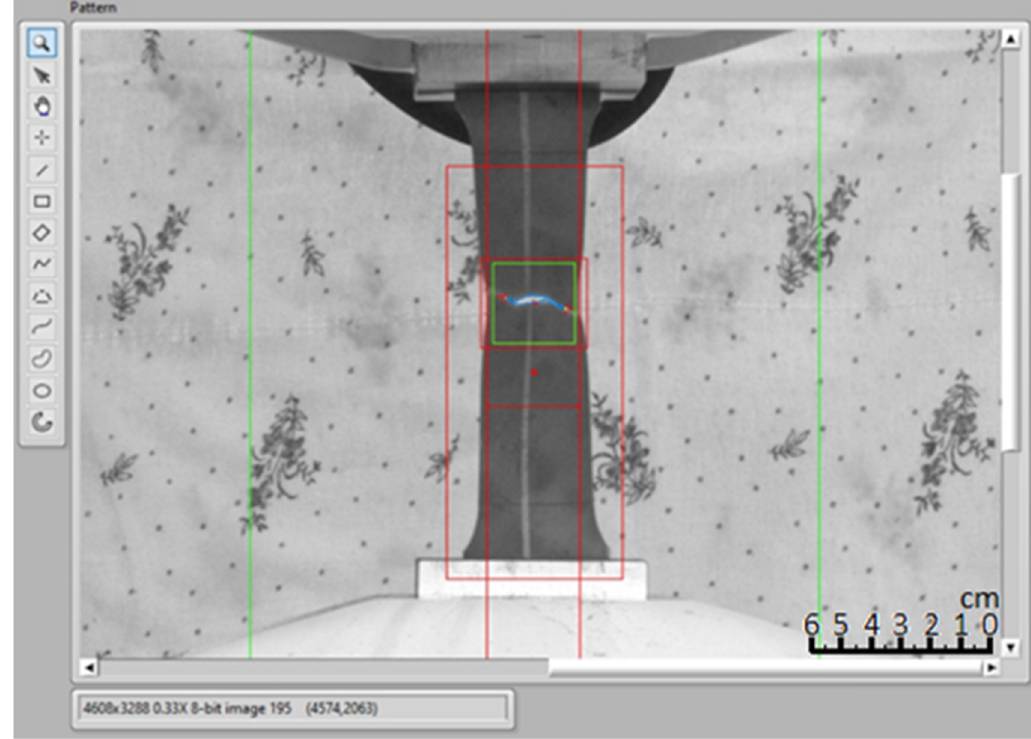
Figure 10. Output image form the camera.